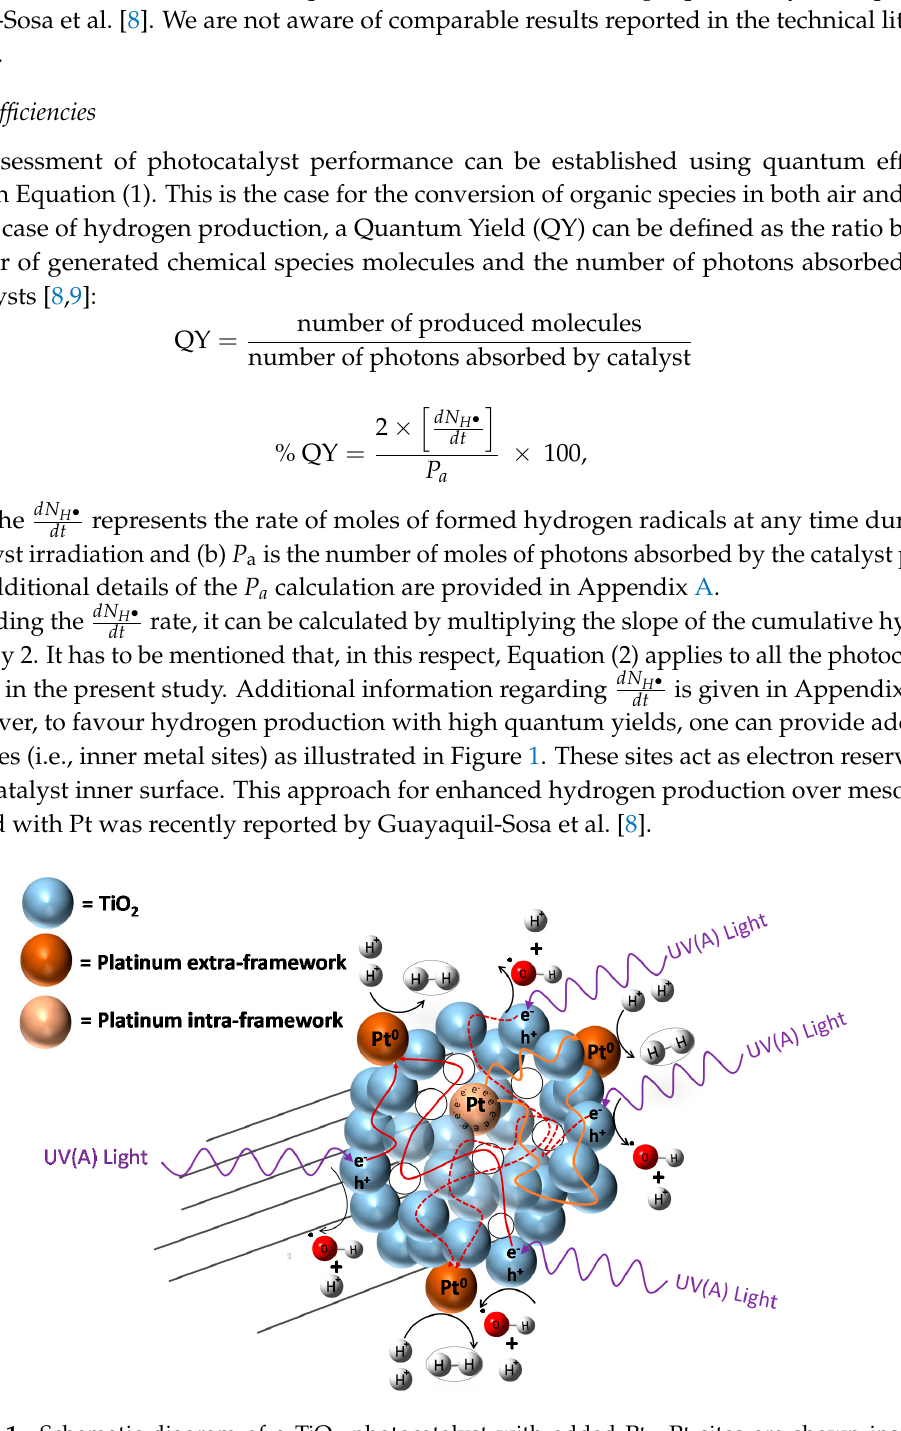
Figure 1. Schematic diagram of a TiO 2 photocatalyst with added Pt. Pt sites are shown inside and outside semiconductor particles. Inner sites are dominant electron reservoirs enhancing hydrogen production.